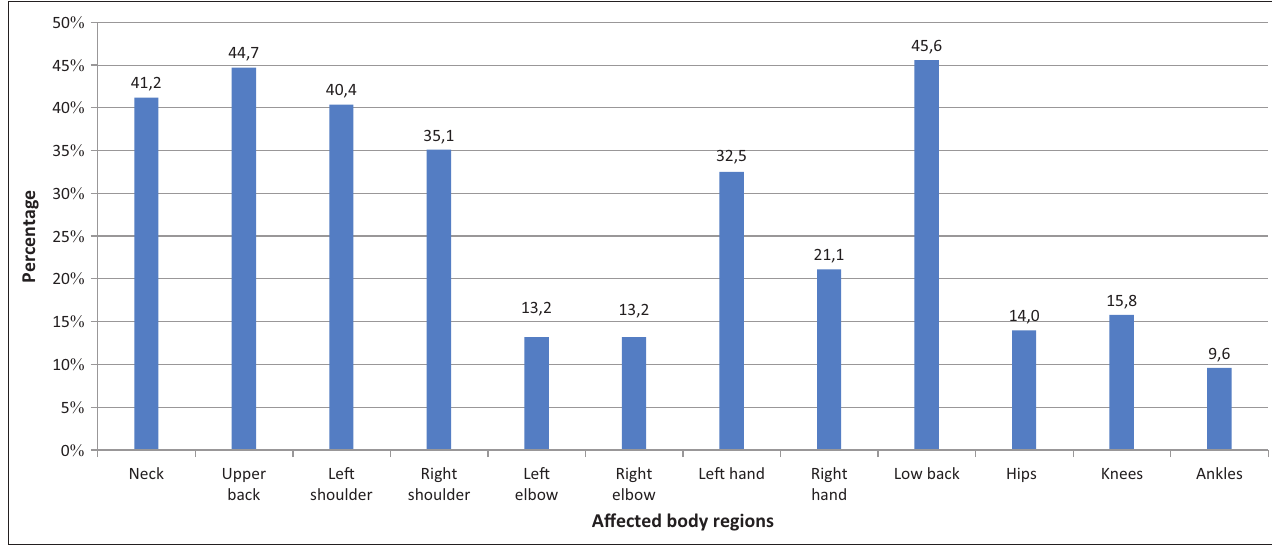
FIGURE 1: General distribution of playing-related musculoskeletal disorders in the 12 anatomic body regions among string instrumentalists.